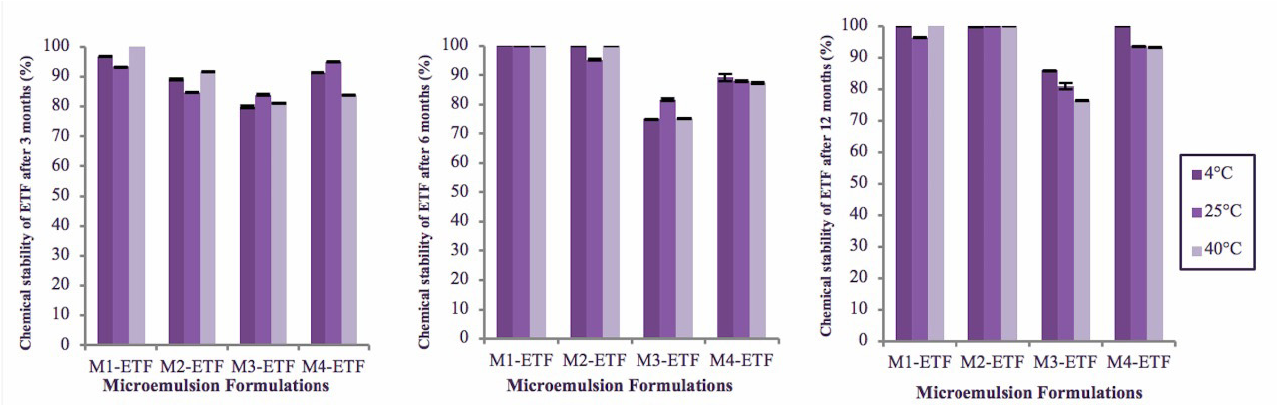
FIGURE 2 - ETF amount change for 3, 6 and 12 months storage at 4 ± 2°C, 25 ± 2°C and 40 ±